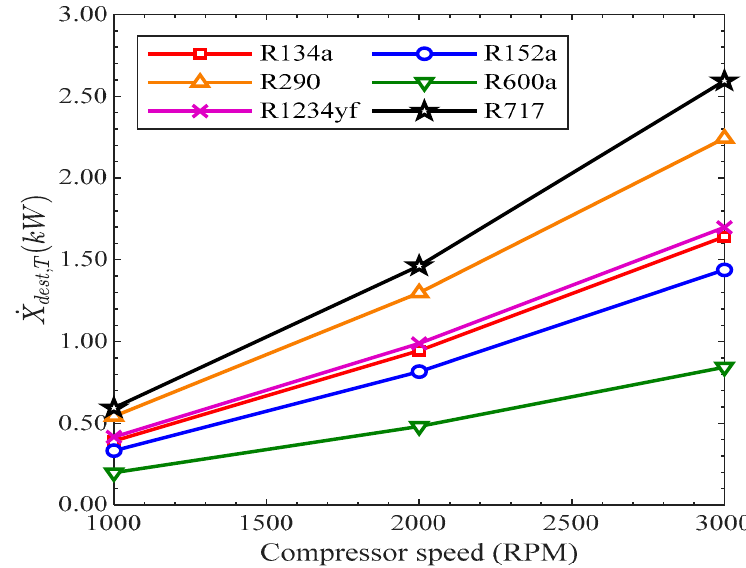
Figure 12 . Total exergy destruction vs. compressor speed .